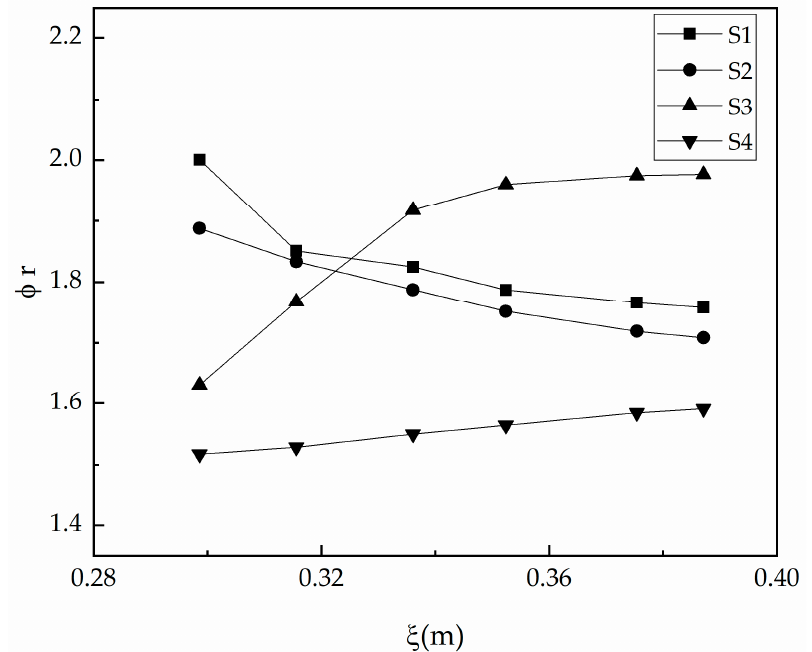
Figure 18. The pile-up coefficient as a function of the penetration depth for different sections.